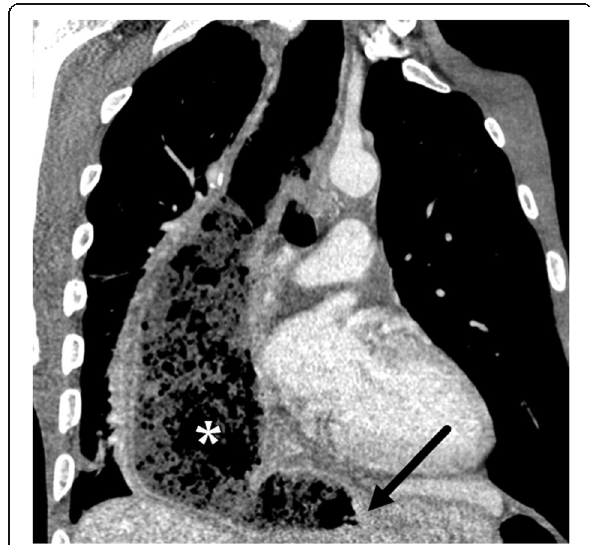
Fig. 11 Primary achalasia. Forty-eight-year-old male with dysphagia and weight loss. Coronal CT image shows markedly dilated esophagus with an air-debris level (asterisk). An abrupt stricture (arrow) is seen in the lower esophagus (bird beak